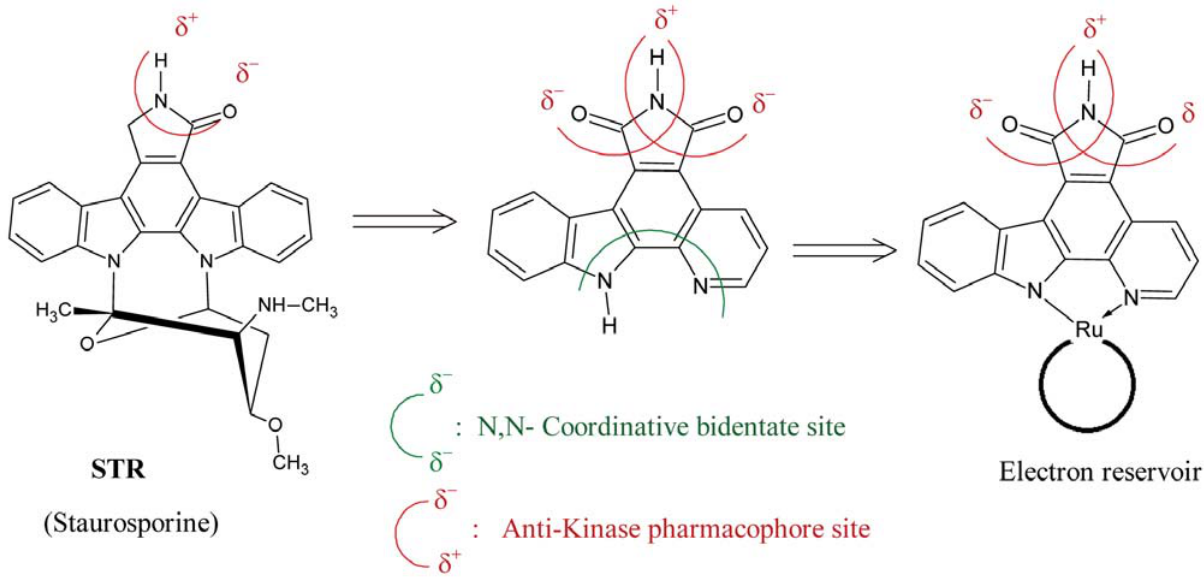
Figure 2. Series of Ru-staurosporine complexes with anti-tumoral pharmacophore site.